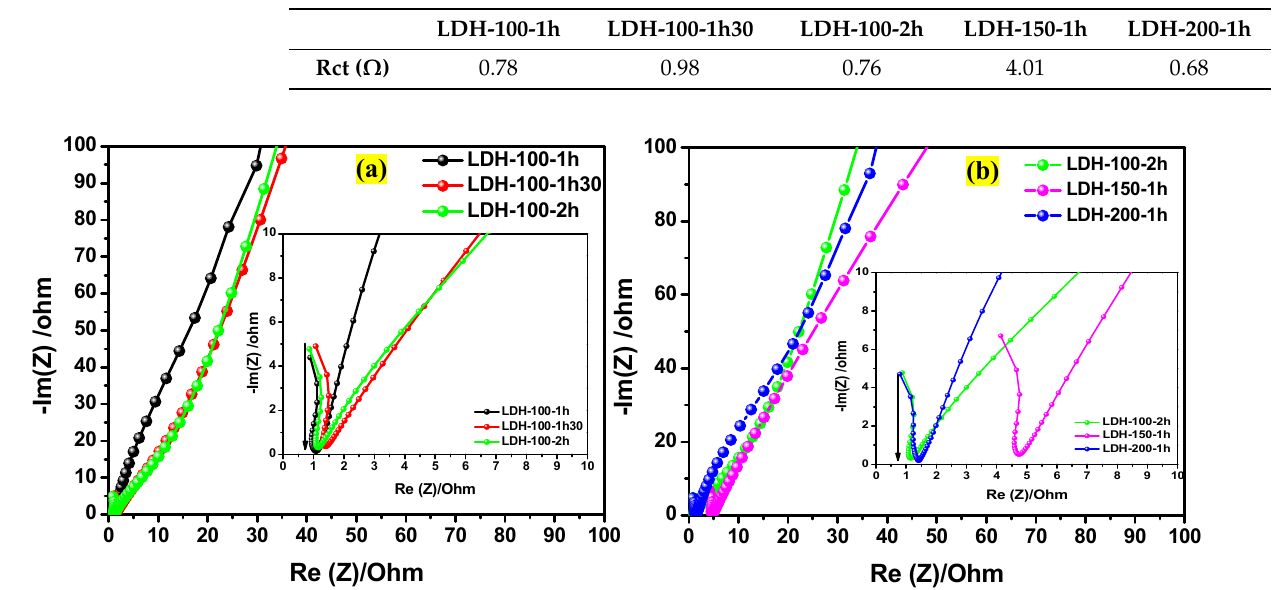
Table 4. Rct values for all the electrodes.